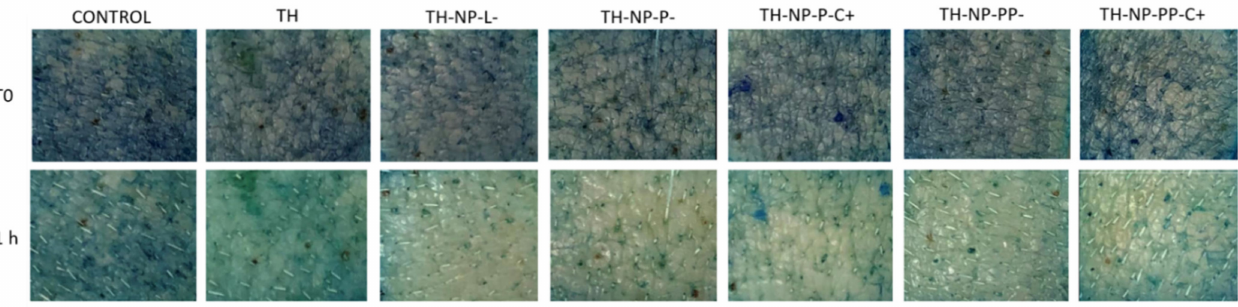
Figure 4. Ex vivo antioxidant activity by methylene blue reduction in pig skin. Images recorded at time 0 and 1 h of the studied compounds (control, free TH, TH-NP-L-, TH-NP-P-, TH-NP-P-C+, TH-NP-PP- and